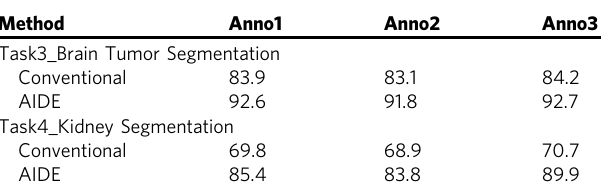
Table 5 Segmentation performance (DSC: %) of Task3_Brain Tumor Segmentation and Task4_Kidney Segmentation on the QUBIQ